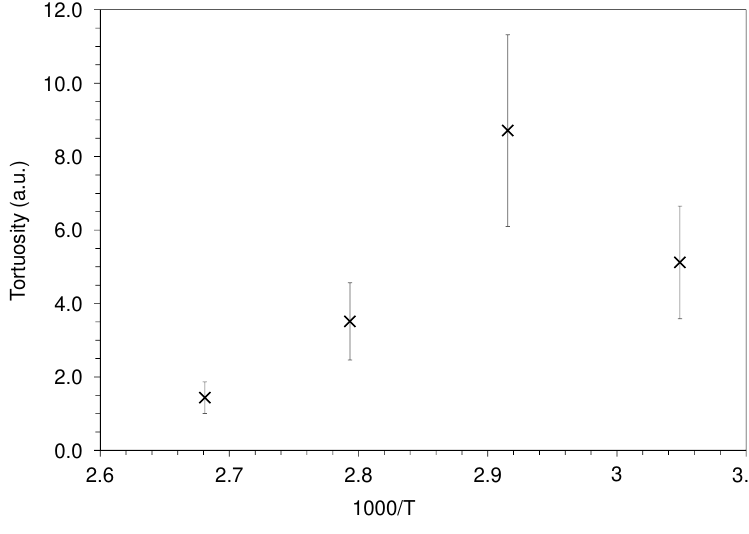
Figure 7. Tortuosity values as a function of